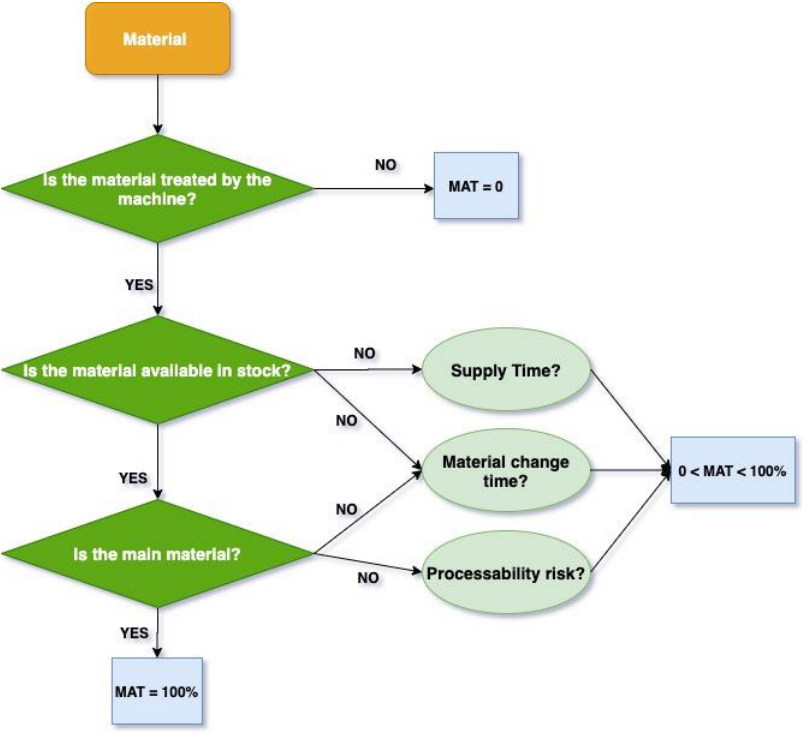
Figure 2. Flow chart of the material evaluation (MAT) Key Performance Indicator (KPI).